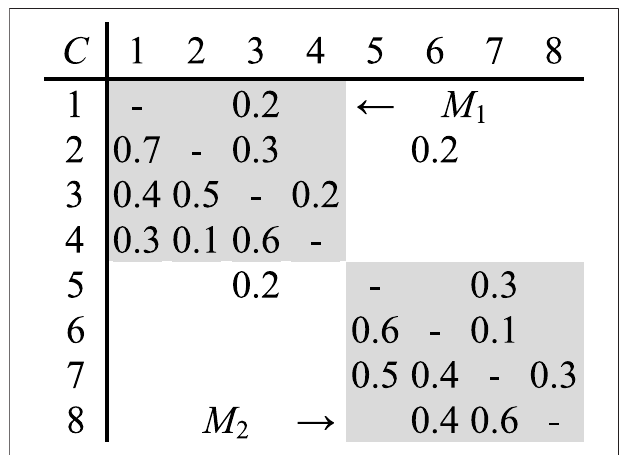
FIGURE 1 | Design dependency matrix with two